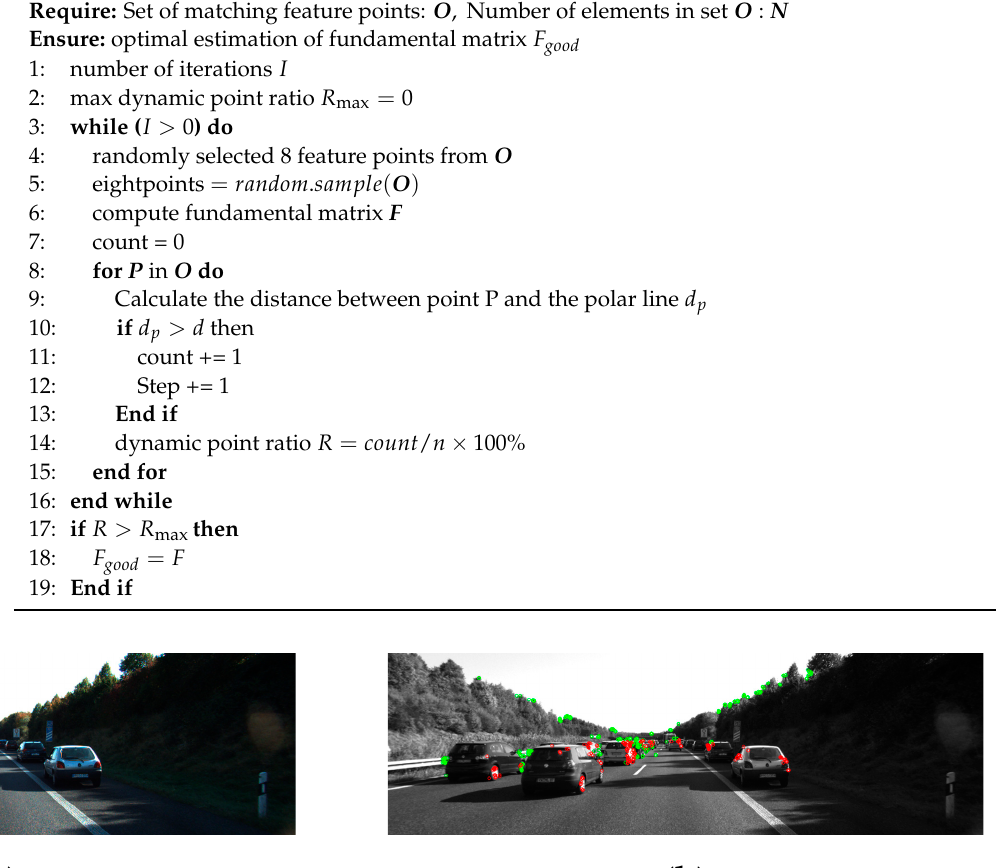
Algorithm 1 RANSAC-based method for optimal estimation of fundamental matrix